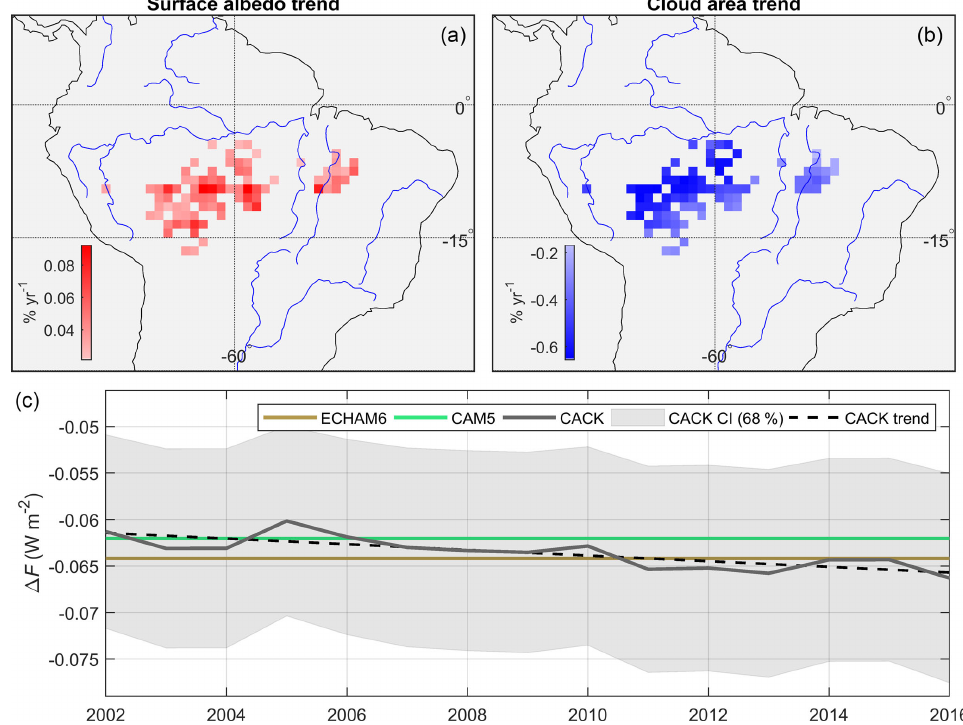
Figure 7. Example application of a temporally explicit CACK; (a) 2001–2016 statistically significant positive trends in all-sky surface albedo derived from CERES EBAF-Surface v4; (b) 2001–2016 statistically significant negative trends in cloud area derived from CERES EBAF-TOA v4; (c) mean (cid:49)F from (cid:49)α s when estimated with the CACK, ECHAM6, and CAM5 surface albedo change kernels. (cid:49)F is the mean of all grid cells plotted in panel (a) . The 1 σ confidence interval (“CI”) shown for CACK excludes the uncertainty component related to physical